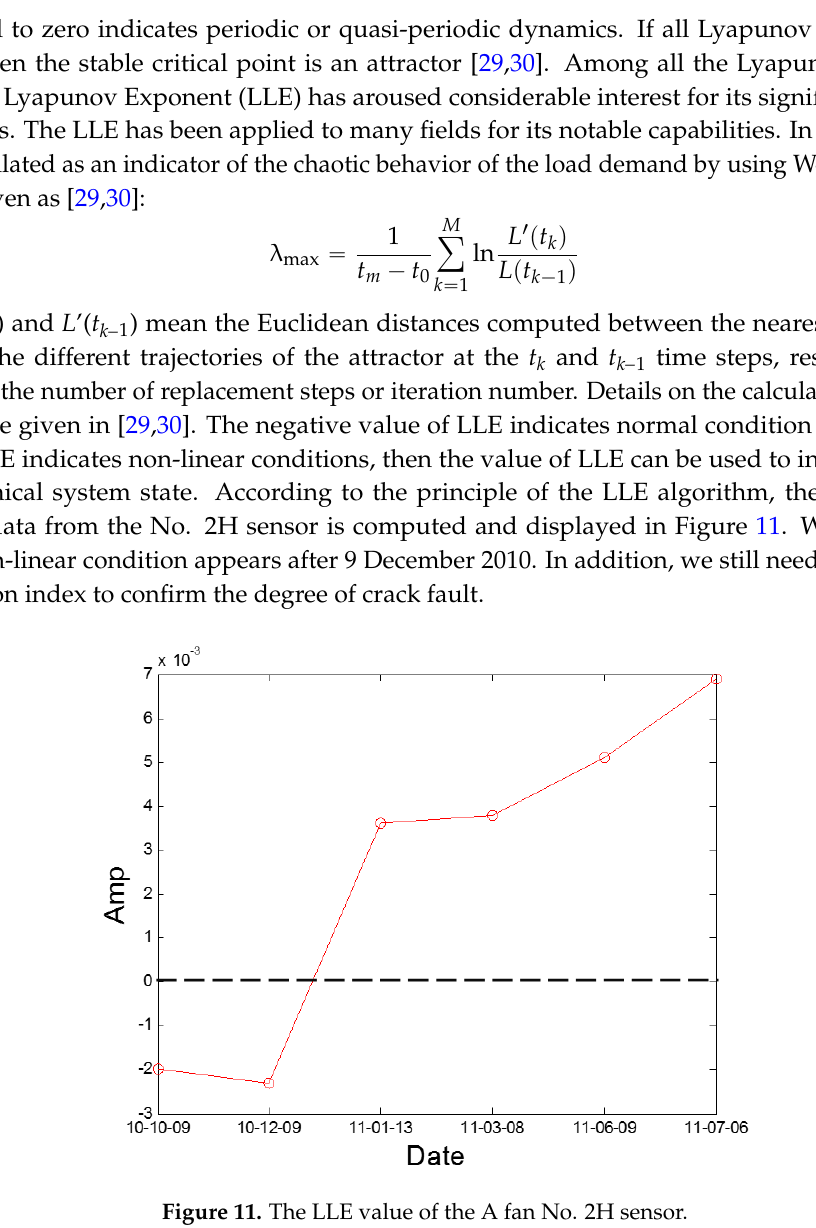
Figure 11. The LLE value of the A fan No. 2H sensor.